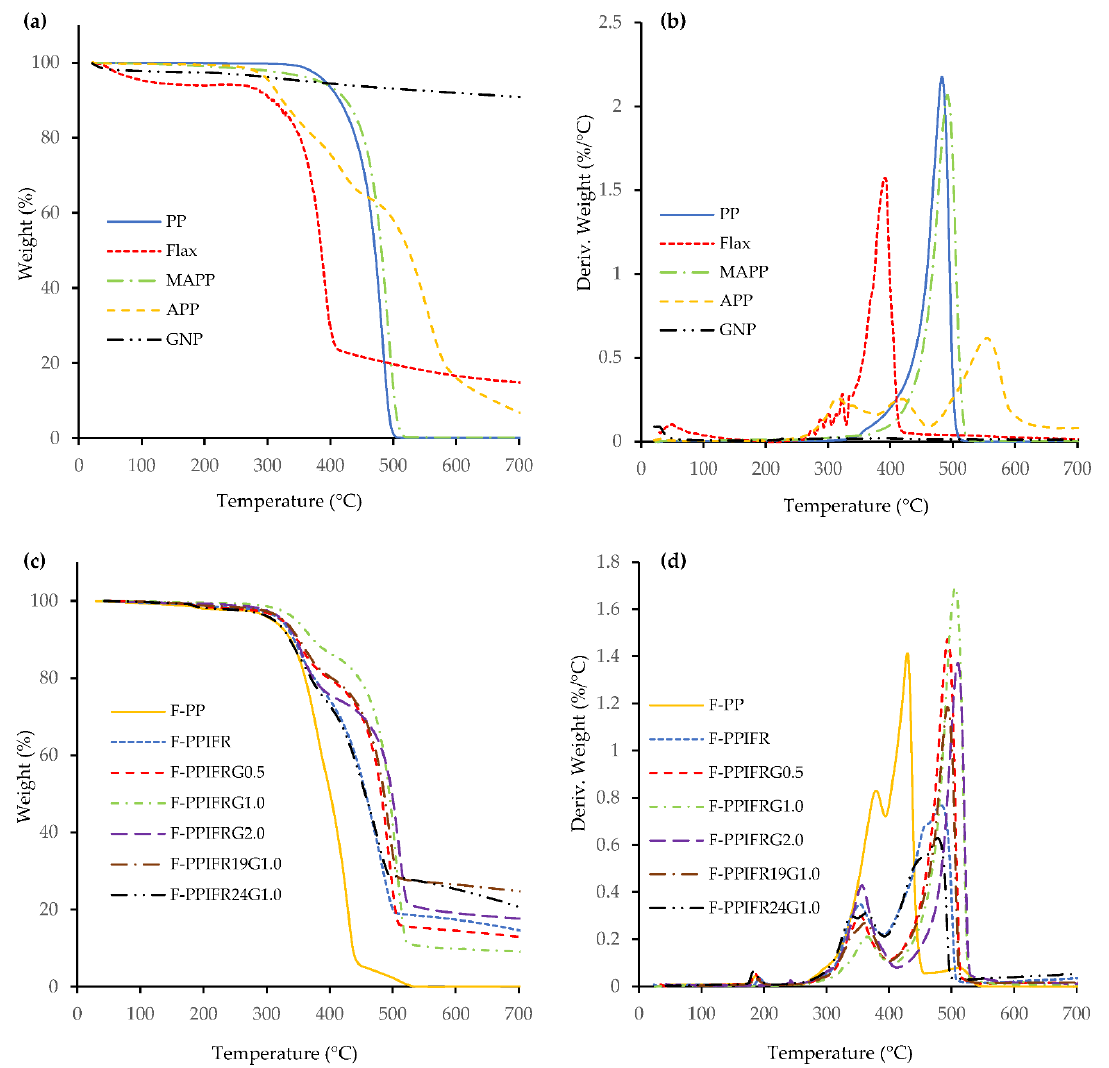
Figure 6. TG and DTG curves of neat materials ( a , b ) and their composites ( c , d ). Interestingly, the F-PPIFR1.0 composite shows the lowest decomposition rate at T max1 (around 370 C) but the highest decomposition rate at T max2 (about 500 C). It is understood that strong interfacial bonding between PP and GNP resulted in higher resistance against thermal degradation at T max1 , but as the temperature increases, the interfacial adhesion begins to weaken, resulting in a higher decomposition rate [11,39]. F-PPIFRG2.0, due to poor interfacial adhesion between PP and GNP, displays a higher decomposition rate at T max1 , whereas the second stage of decomposition occurs at a higher temperature because of the high thermal resistivity of GNP. The addition of 19 and 24 wt% IFR to the F-PP composite with 1.0 wt% GNP leads to further reduction in the decomposition rate, with the increase in final residue at 700 C [22].